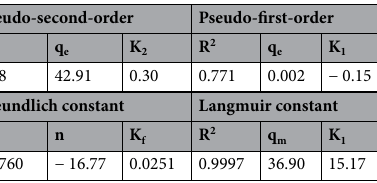
Table 5. Kinetic and isotherm parameters for the removal of